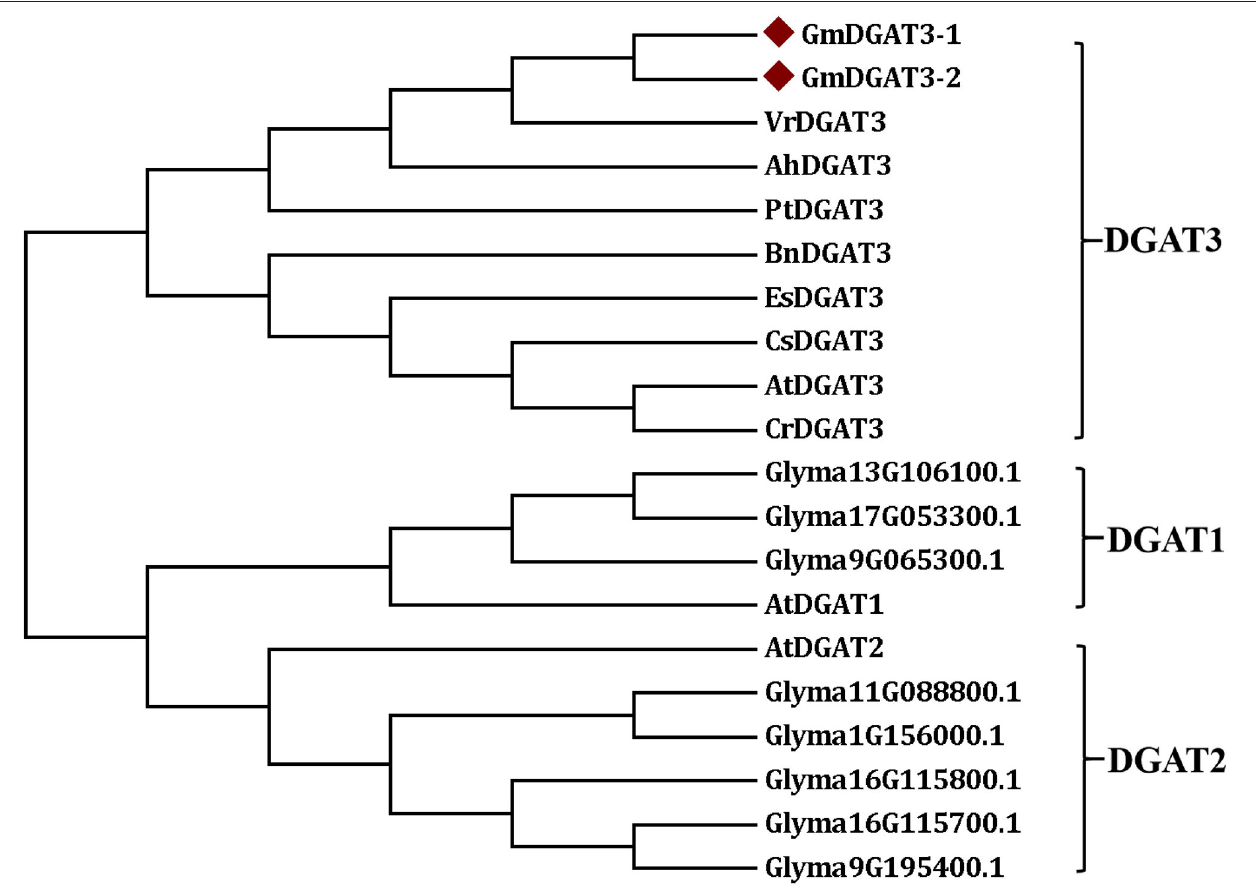
FIGURE 2 | Phylogenetic tree of soybean GmDGAT3s and other plant DGAT3s. The phylogenetic tree was constructed by the Neighbor-Joining method in MEGA6.0. The little red triangle represented soybean GmDGAT3-1 and GmDGAT3-2, respectively. NCBI accession numbers of each DGAT protein were shown in Supplementary Table 1 . Gm/Glyma, Glycine max ; At, Arabidopsis thaliana ; Ah, Arachis hypogaea ; Bn, Brassica napus; Cs, Camelina sativa ; Cr, Capsella rubella ; Es, Eutrema salsugineum ; Pt, Populus trichocarpa ; Vr, Vigna radiate